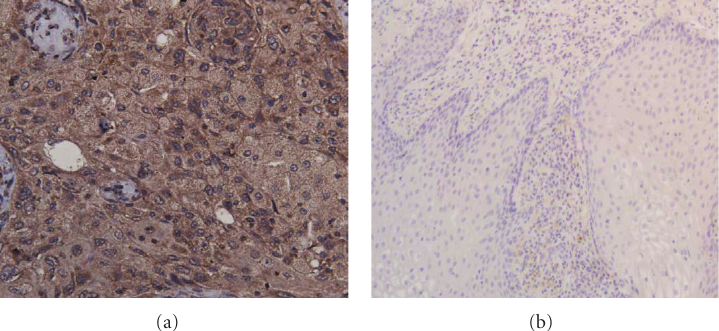
Figure 3: Immunohistochemical analysis of cervical tissues using mouse polyclonal antibody raised against pseudotype VLPs harbouring the p16 INK4A protein. (a) Invasive squamous cell carcinoma; (b) nonneoplastic cervical tissue (condyloma).